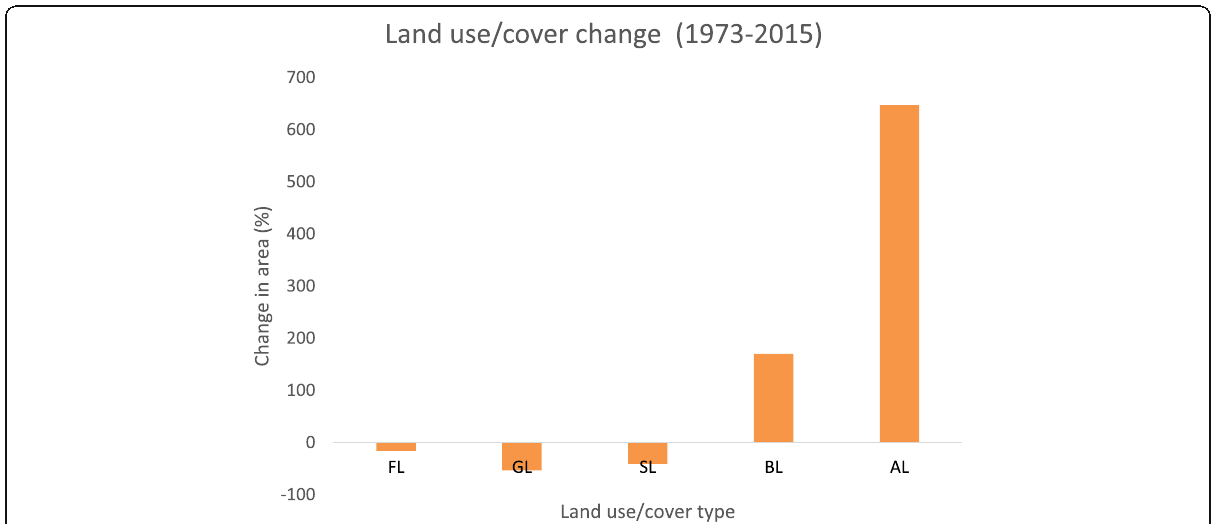
Fig. 6 Diagrammatic illustration of land use/cover change in ha during the last four to five decades (1973 – 2015) in the study area, Sidama highlands of southern